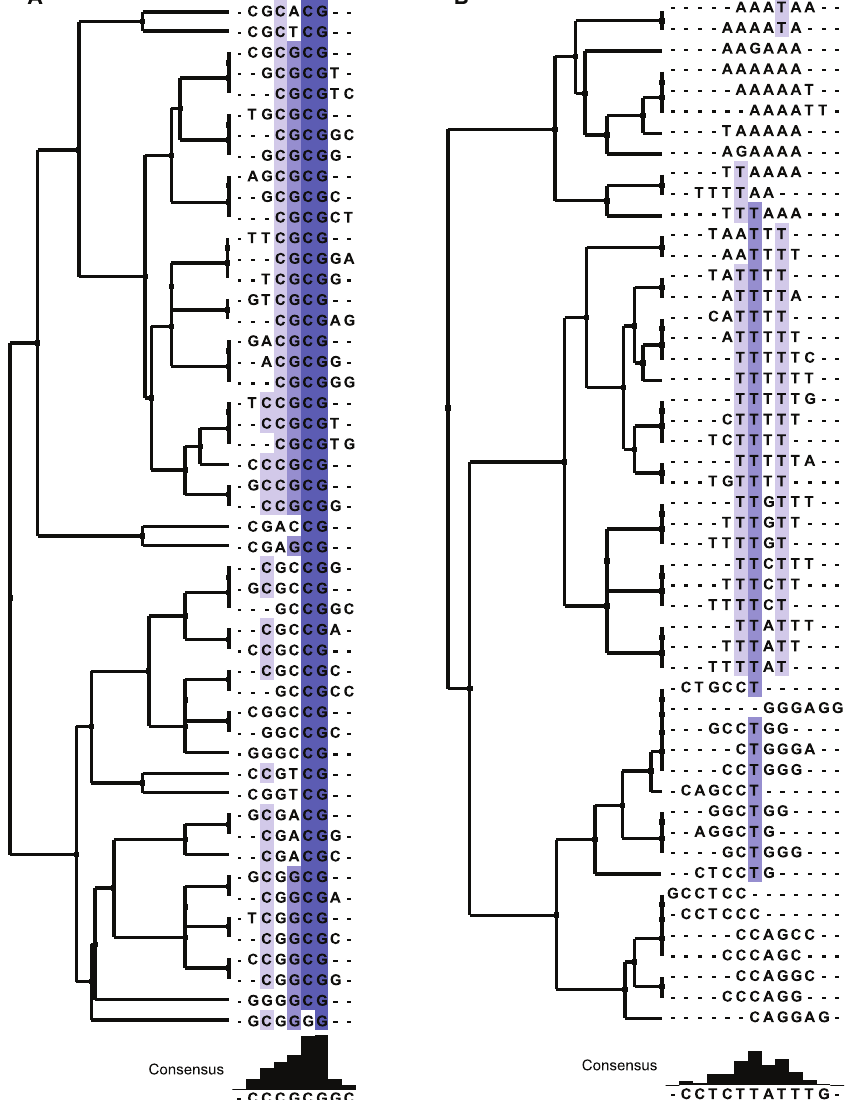
Figure 3. G and C Nucleotides Strongly Dominate the Predicted Motifs Comparison of the top 50 predicted hexamers (A) and the 50 most abundant hexamers in miRNA upstream regions (B) illustrate that the observed abundance of G and C nucleotides in the predicted motifs is not a consequence of nucleotide bias in upstream miRNA